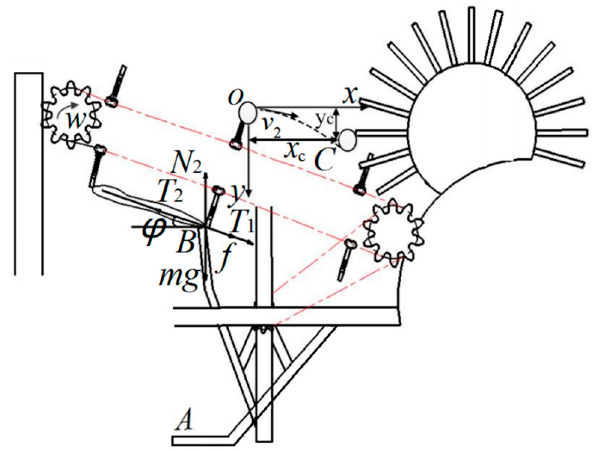
Figure 4. Schematic diagram of the stress of the finger in the adjacent period.